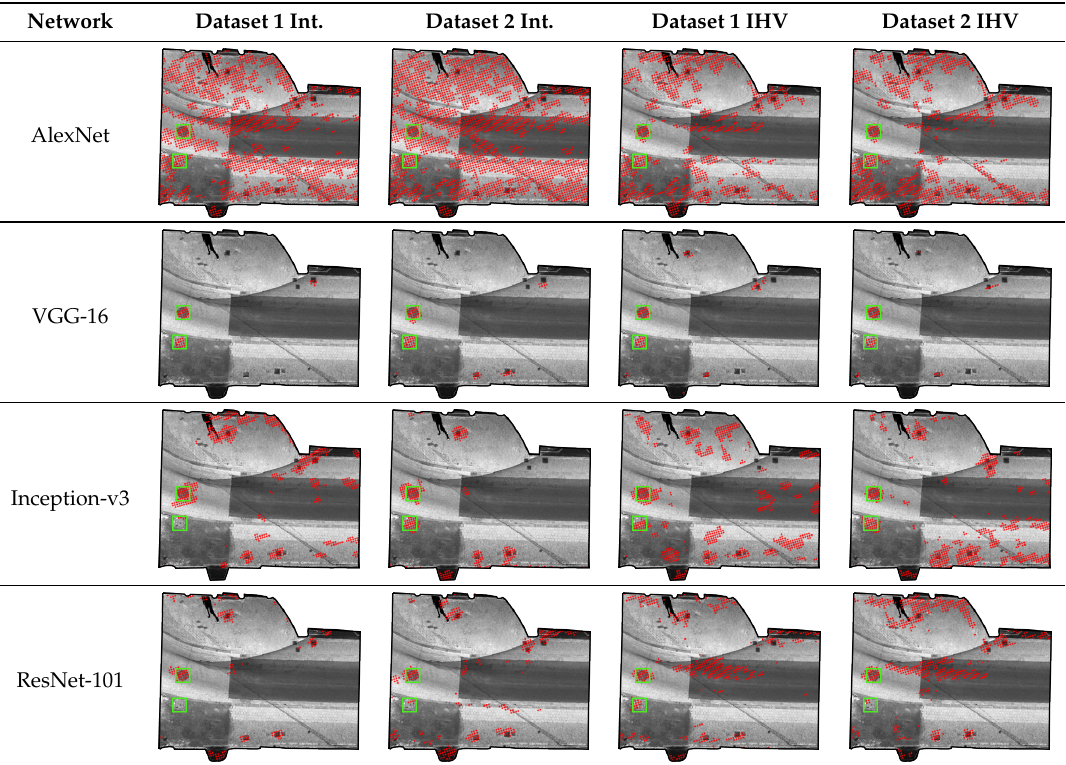
Table 3. Visualization of the sliding window positions with a classification score greater than the classification threshold ( T class = 0.5) for the different networks and training datasets. The two manhole covers in the image are indicated by the green bounding